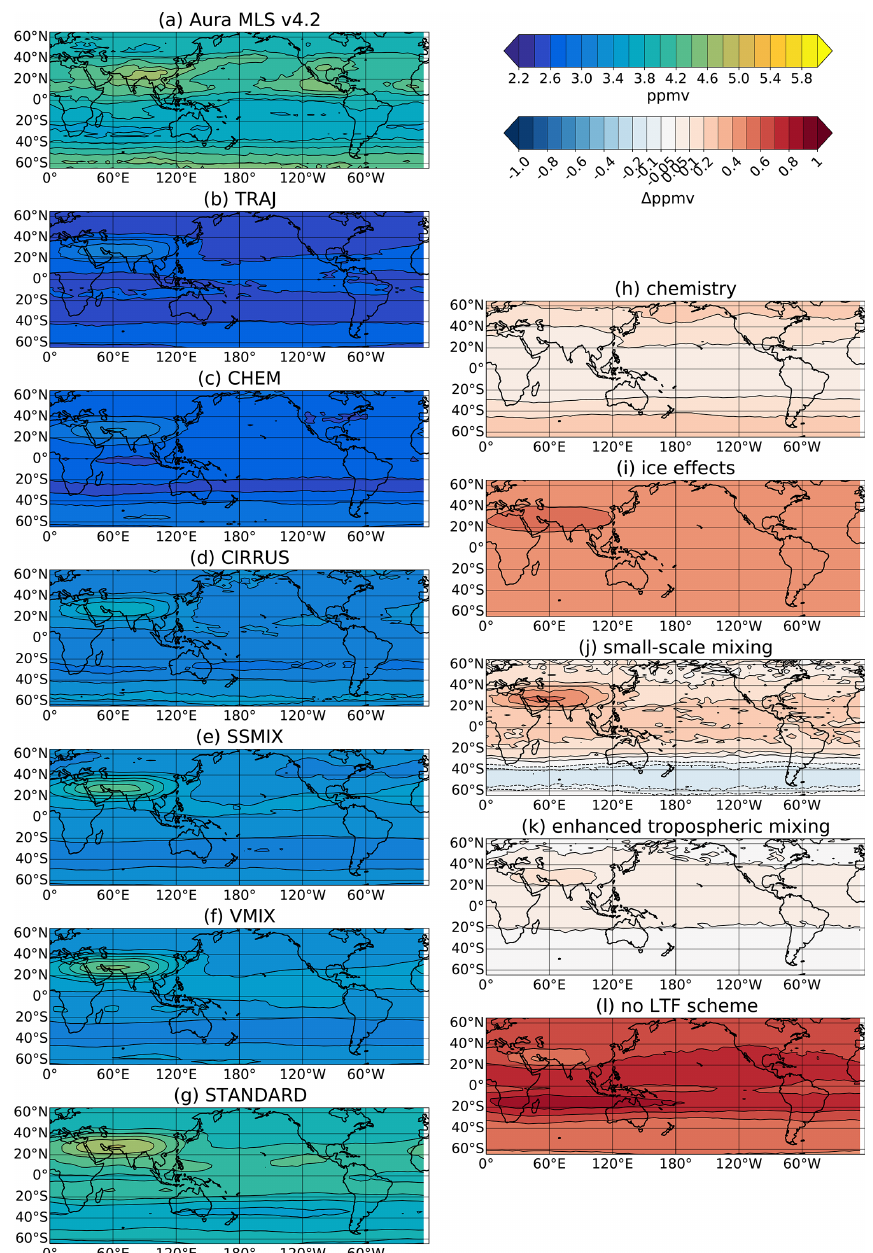
Figure 2. (a–g) Climatology of water vapour distribution at 80hPa during boreal summer (JJA) for the period 2007–2016 from (a) Aura MLS v4.2 observations, (b) TRAJ, (c) CHEM, (d) CIRRUS, (e) VMIX, (f) SSMIX experiments and (g) STANDARD simulation. (h–l) Isolated effect of each (h) chemistry, (i) cirrus, (j) small-scale mixing, (k) enhanced tropospheric mixing and (l) no-LTF scheme. Air parcels have been binned to a 5 ◦ longitude × 2 ◦ latitude